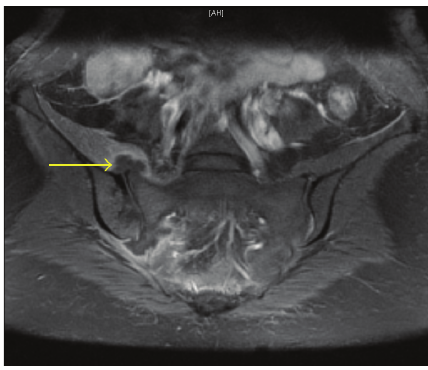
Figure 1: Bilateral sacroiliitis with right sacroiliac joint